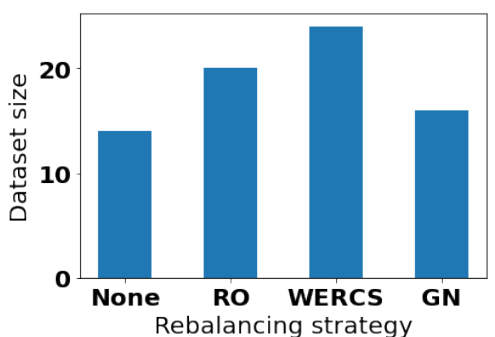
Figure 5. The dataset sizes for the different rebalancing strategies when applied to the demonstration